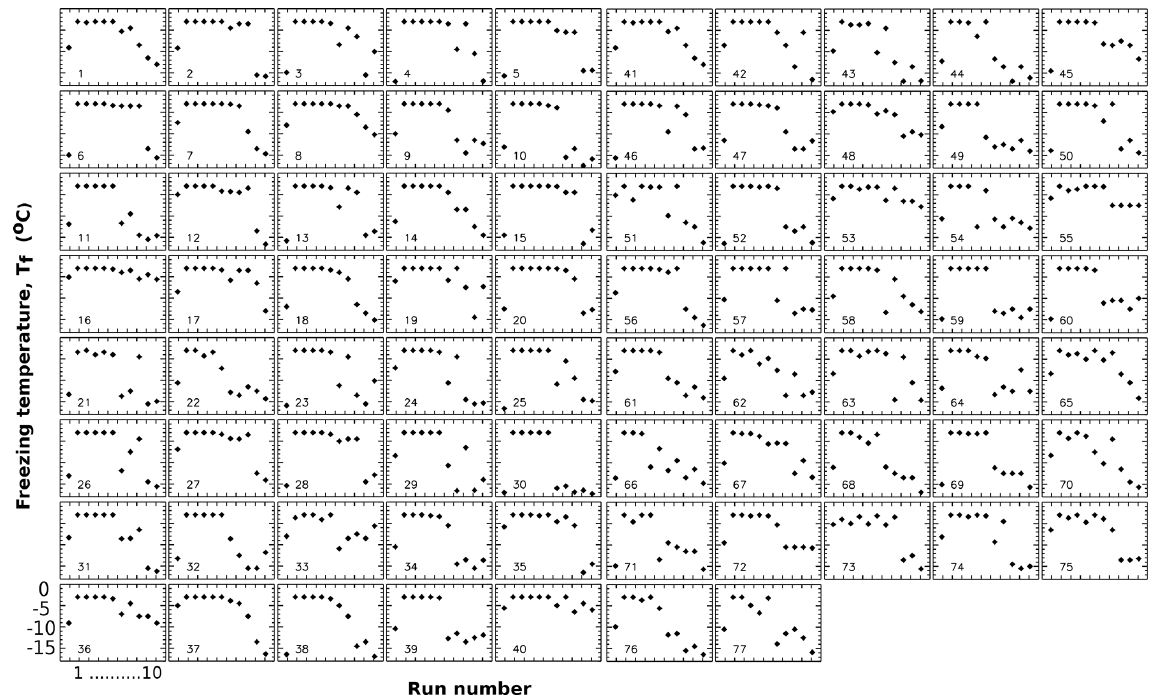
Figure 6. Freezing temperatures in Exp. A for run 0 and runs 1 to 10 for individual drops. Run 0 is the initial run, and runs 1 to 10 are runs with controlled T w values as shown in Table 1.